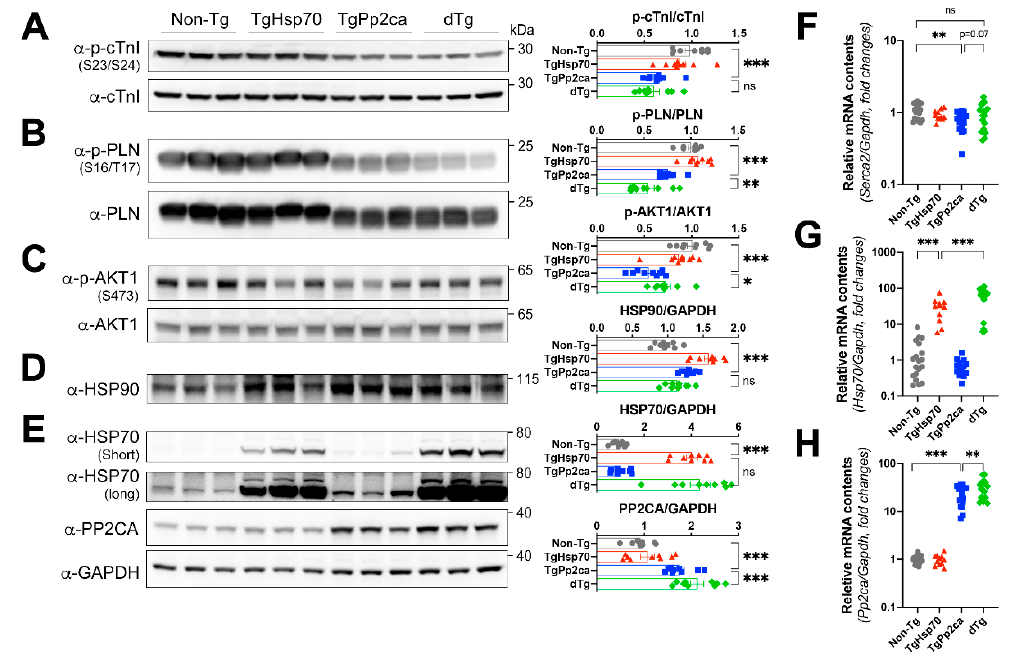
Figure 6. Phosphorylation levels of select proteins in hearts from each group of transgenic mice at 6 months of age. ( A , B ) Calcium handling factors. Known PP2CA substrates related to the failing heart phenotype were assessed. Phosphorylation of cardiac troponin I (Ser23/24) ( A ) and phospholamban (Ser16/Thr17) ( B ) was significantly reduced in TgPP2CA mice, and expression of HSP70 did not affect these changes in phosphorylation. Known factors associated with HSP70 were also assessed, and the phosphorylation levels of protein kinase B (Ser473) (AKT1, C ). ( D ) HSP90, an important binding partner of HSP70, was measured. HSP90 levels were significantly increased in transgenic mice. Western blotting ( E ) and real-time PCR ( G , H ) also confirmed transgenic overexpression of PP2CA and HSP70 in the relevant groups. ( F ) Individual dot plots beside Western blot depict densitometer analysis. Transgenic expression of PP2CA attenuated SERCA2 mRNA levels in the heart, whereas transgenic HSP70 expression partially restored it. ( F – H ) Cohort size, nTg: 19, TgHSP70: 11, TgPP2CA: 15, dTg: 17. One-way ANOVA and LSD post hoc testing were performed. * p < 0.05; ** p < 0.01; *** p < 0.001; ns, not significant. Displayed figures are representative images of three independent experiments.